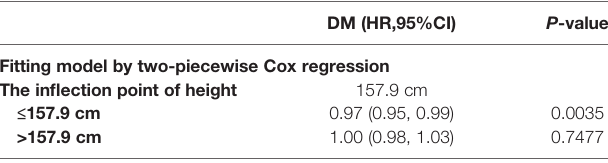
TABLE 4 | The result of the two-piecewise Cox regression model. TABLE 5 | Strati fi ed association between height and DM by age and BMI in